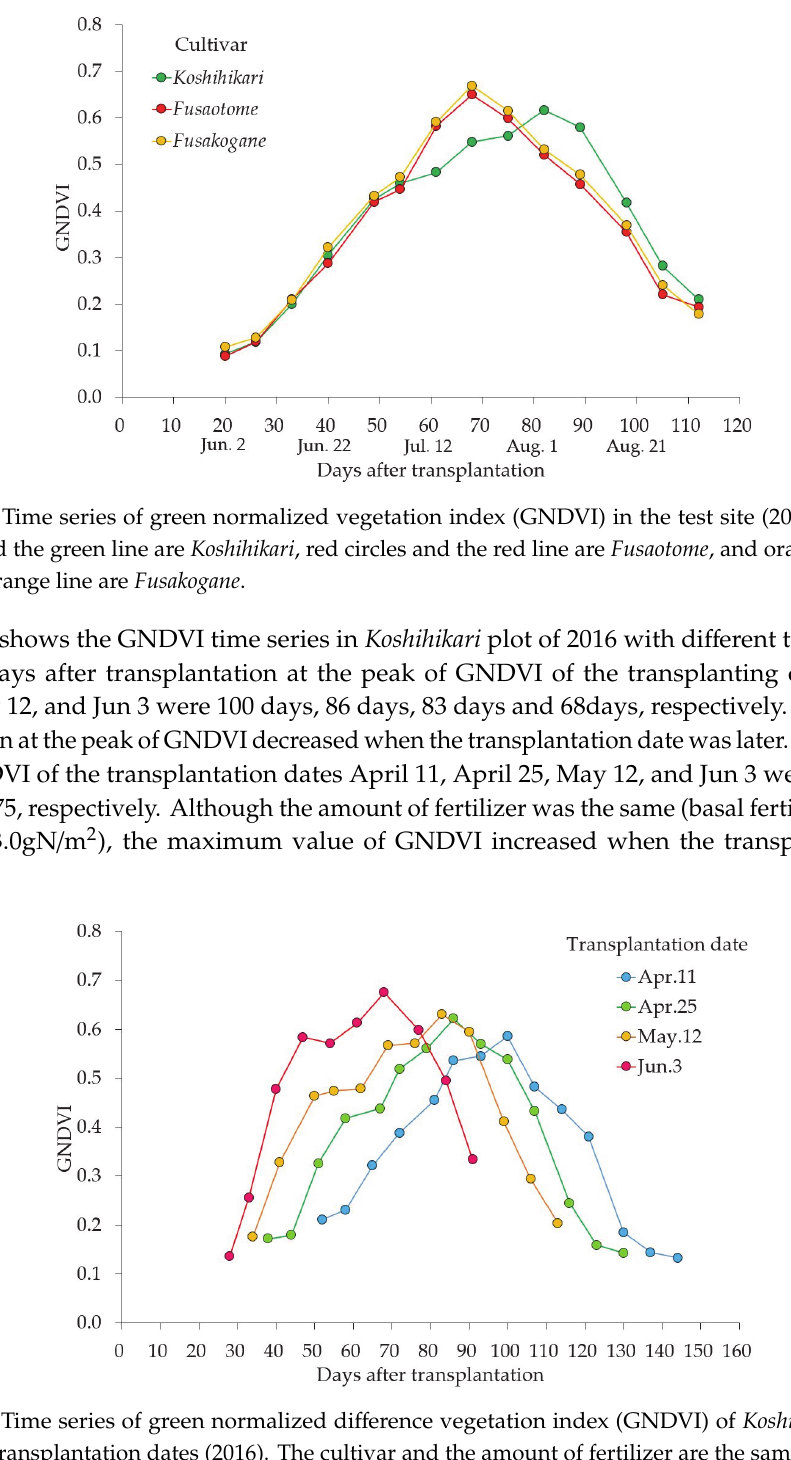
Figure 5. Time series of green normalized di ff erence vegetation index (GNDVI) of Koshihikari with di ff erent transplantation dates (2016). The cultivar and the amount of fertilizer are the same. The blue line denotes the time series of GNDVI of the transplantation date April 11, the green line shows the time series of GNDVI of the transplantation date April 25, the orange line shows the time series of GNDVI of the transplantation date May 12, and the red line shows the time series of GNDVI of the transplantation date Jun